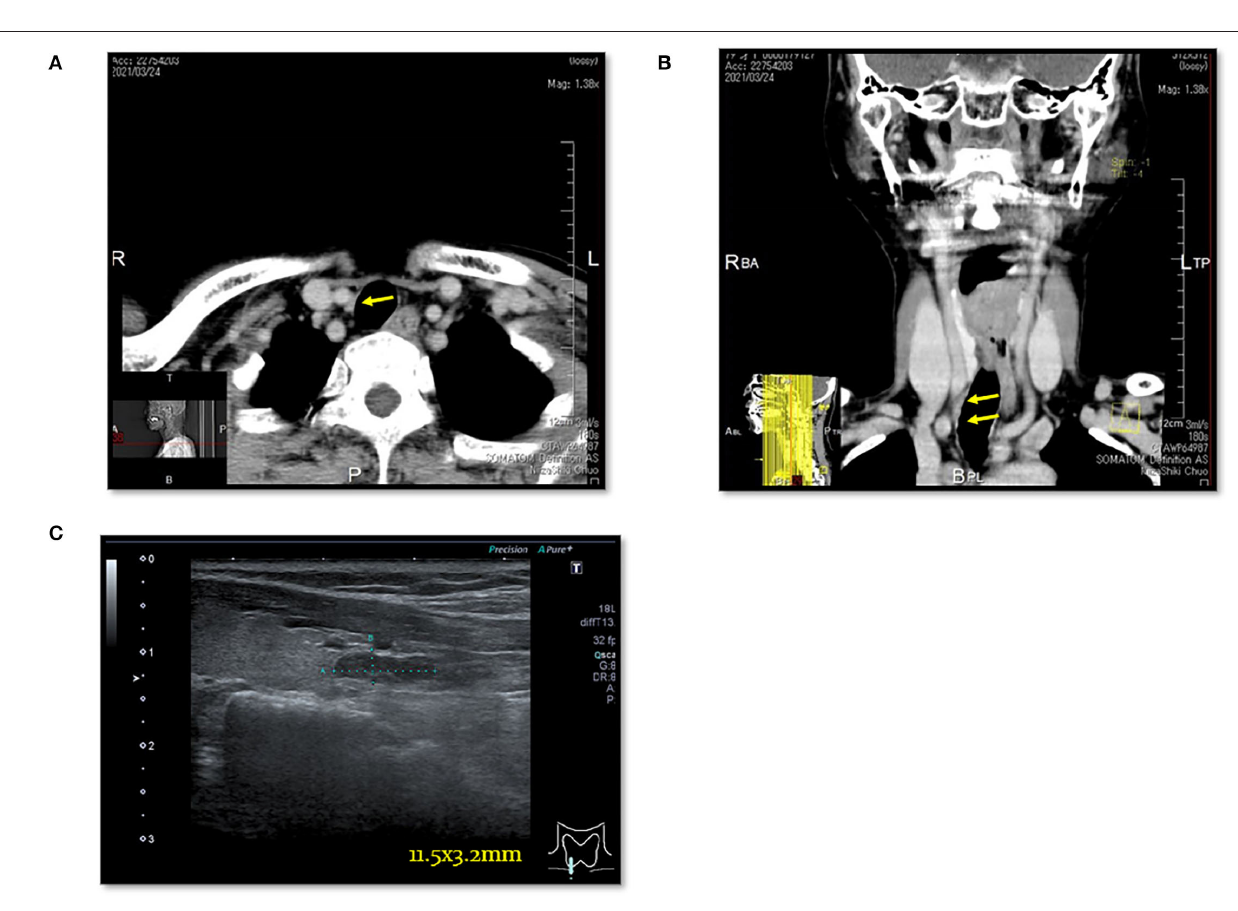
Frontiers in Surgery |